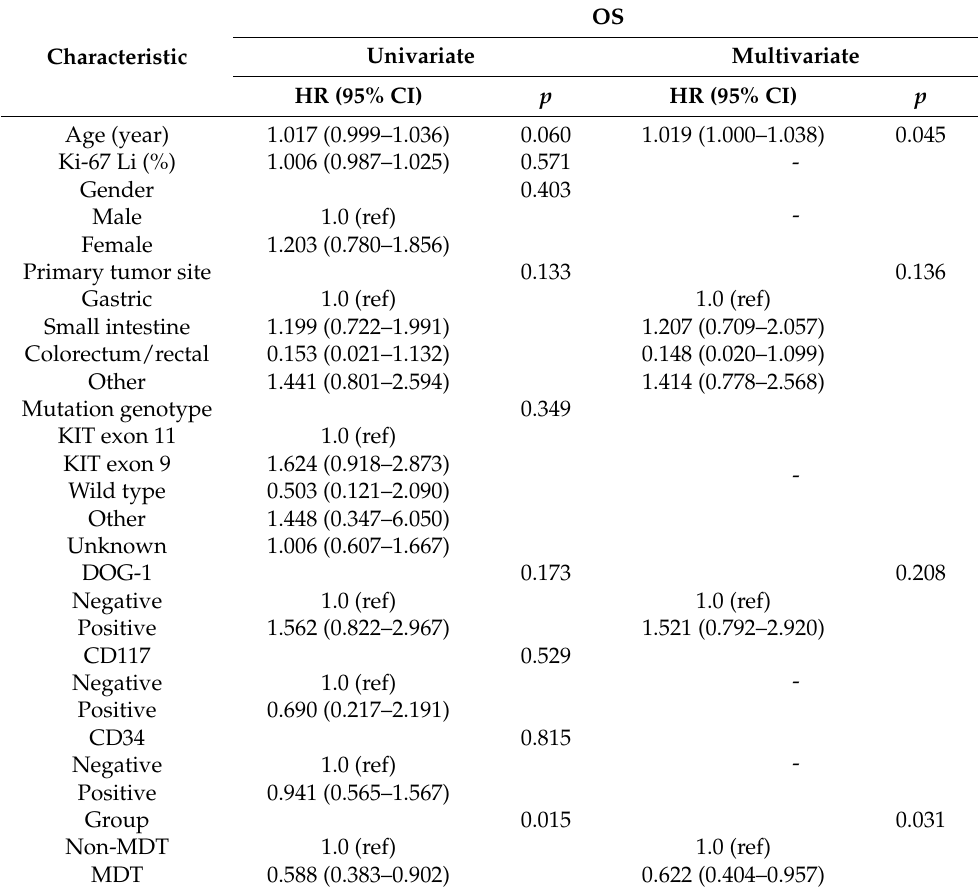
Table 2. Univariate and multivariate Cox analyses of prognostic factors for OS in patients with advanced